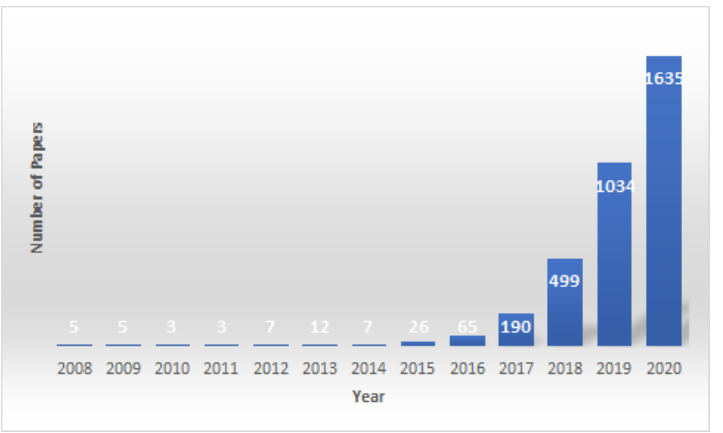
Figure 1. This figure shows the number of published papers using deep learning models to predict cancer risk, classification, prediction and detection per year since 2008. The data were collected using keyword searches through